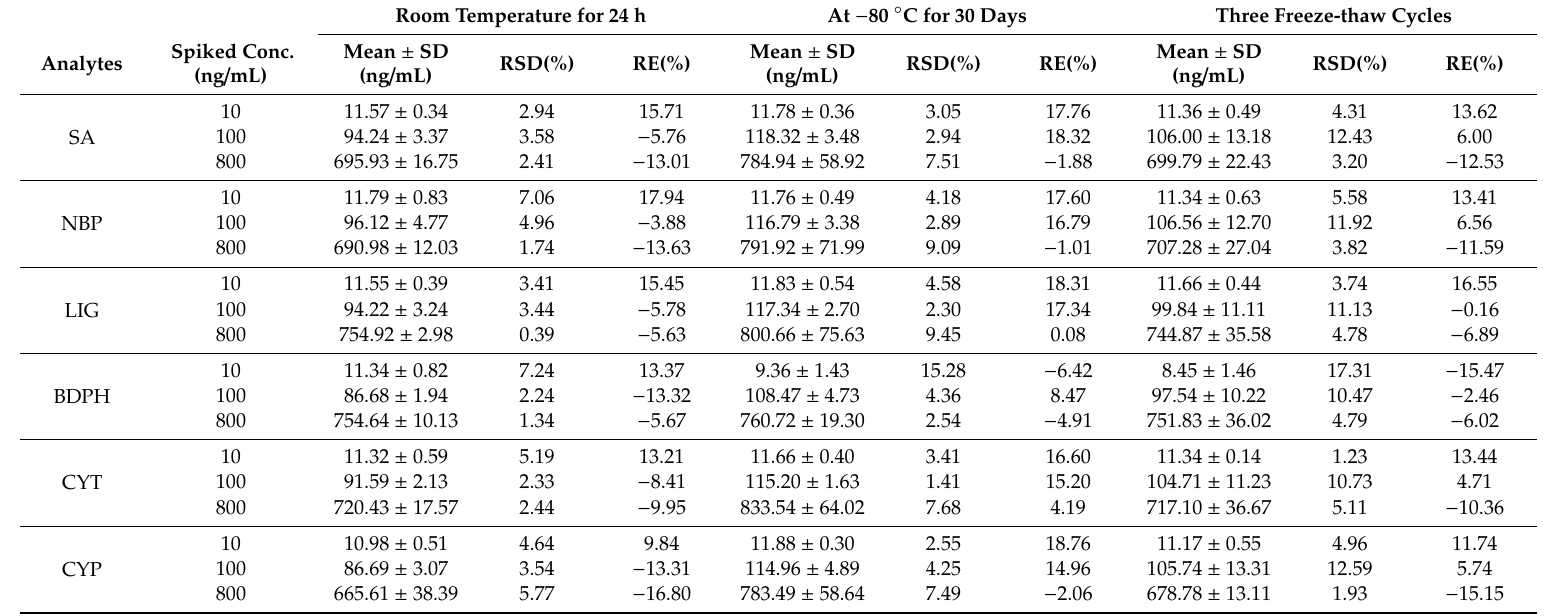
Table 6. Stability results of the analytes in rat cerebral cortex homogenate under three di ff erent conditions ( n =